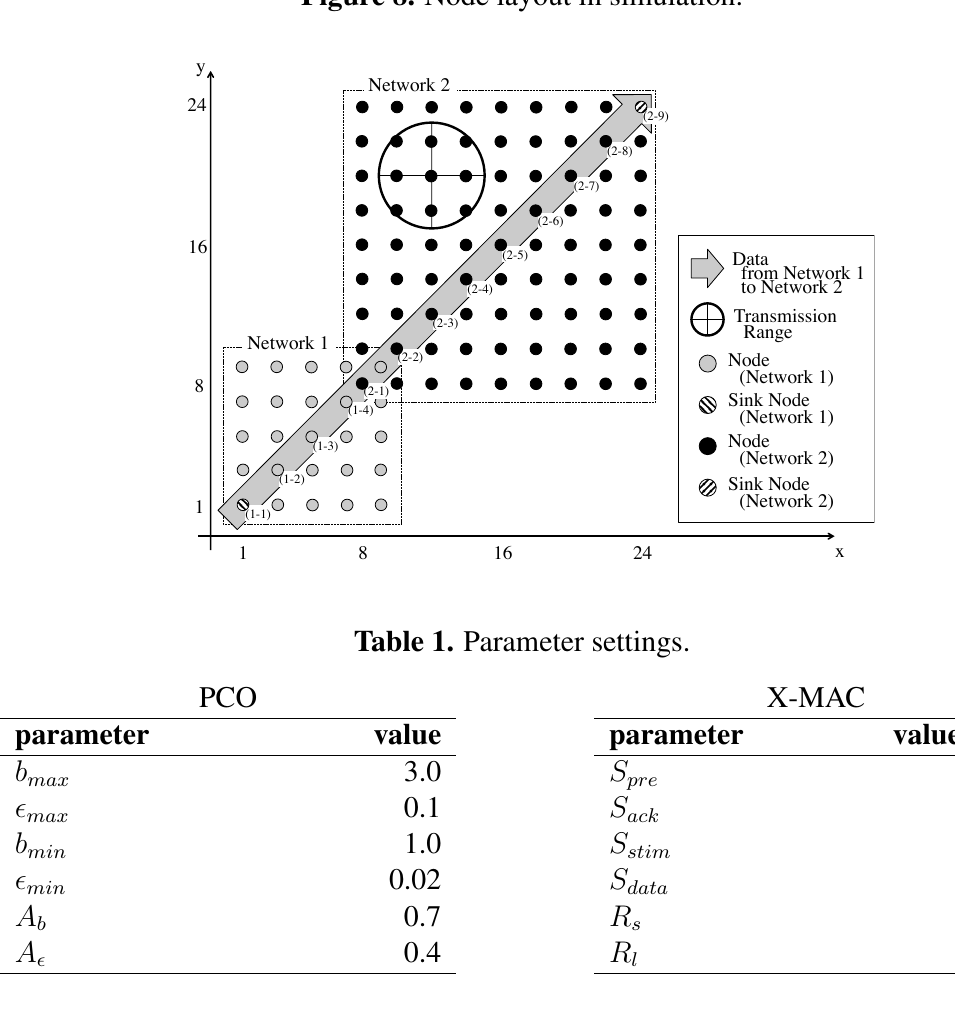
Figure 8. Node layout in simulation.